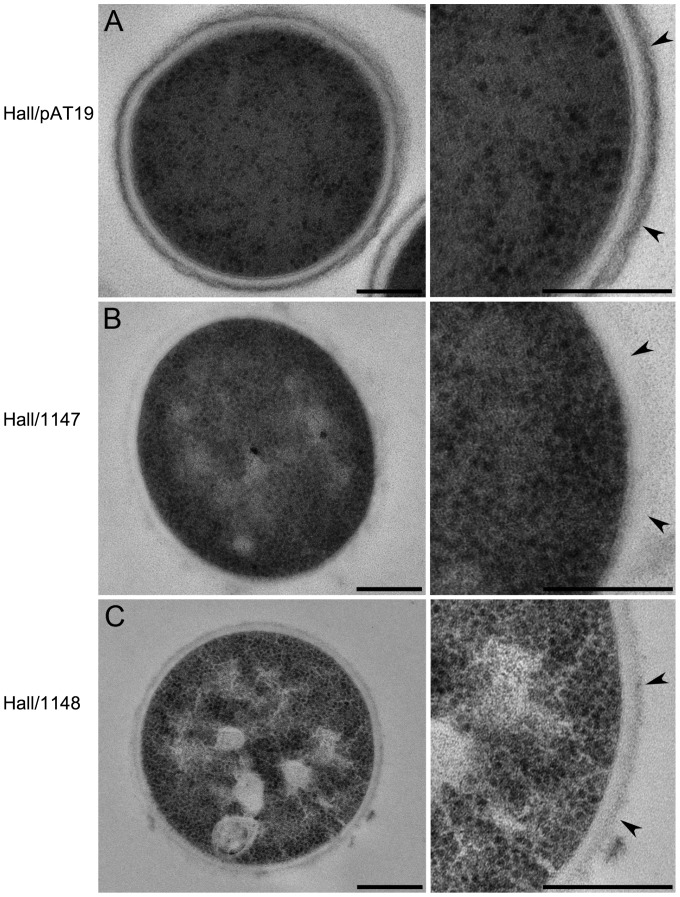
Ultrastructural morphology of Hall/pAT19, Hall/1447, and Hall/1148.Bacteria from a 5 h culture in TGY were treated by high pressure and freeze substitution and then observed by electron microscopy. Hall/pAT19 (A) showed a well delineated wall, whereas in Hall/1147 (B) and Hall/1138 (C) the bacterial wall is transparent, almost invisible. In addition, Hall/1148 (C) showed numerous transparent inclusions. All scale bars represent 200 nm.